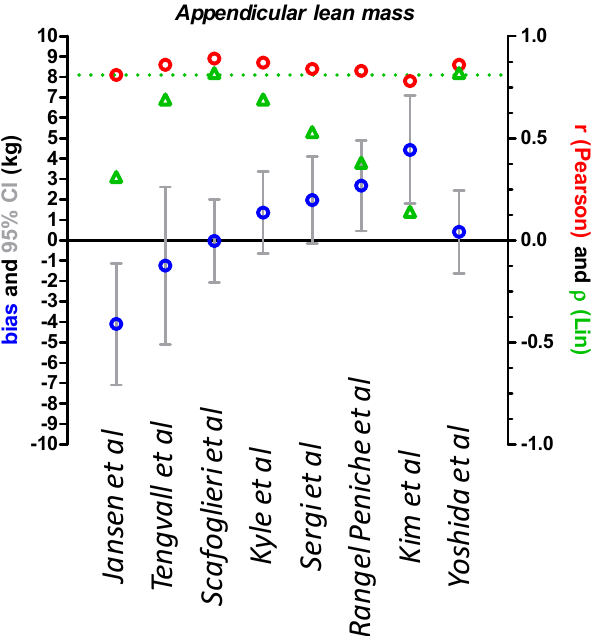
Figure 2. Comparison of appendicular lean mass measured by DXA and BIA according to BIA specific equations. Appendicular lean mass (ALM) values from 115 severely anorectic patients were compared with a Bland–Altman test. Bias (DXA – BIA values) and 95% confidence intervals (95% CI) are shown in blue and gray, respectively. Pearson correlations were performed and Pearson r is shown in red circles. The concordance coefficient of Lin ρ was calculated and is shown in green triangles. The green dashed line represents the cut-off at 0.81 to consider ρ fairly good. DXA: dual X ray absorptiometry; BIA: Bioelectrical impedance analysis.